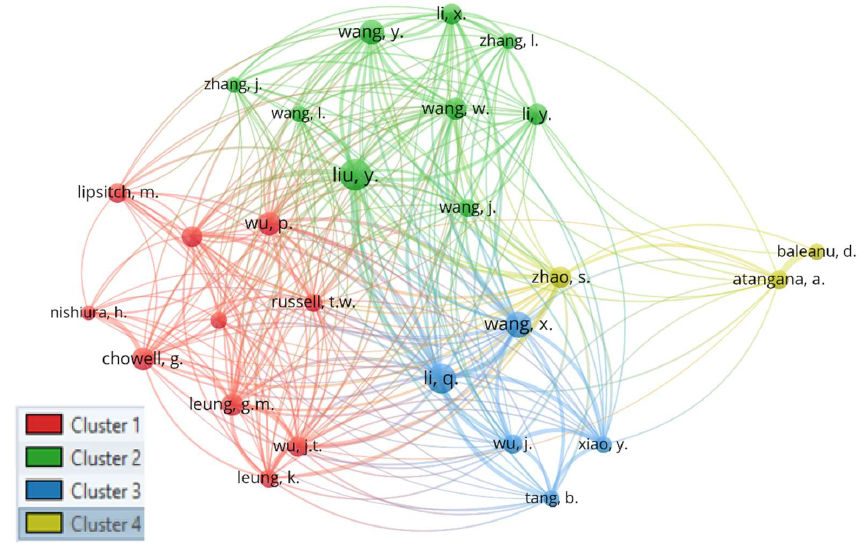
Figure 3. Co-citation network.